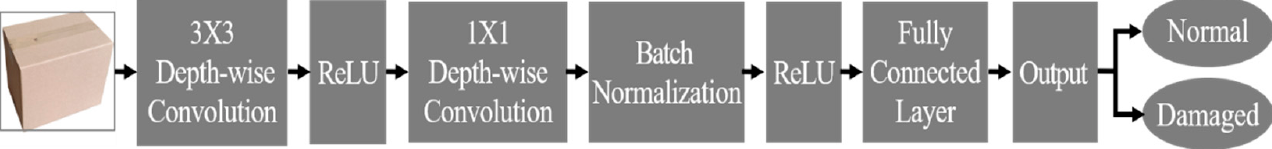
Figure 5. A flow chart for classification of parcel boxes. 3.4. Dataset of Materials and Method The experiment for the recognition and classification of damaged parcel boxes used in this paper was performed by Google, as shown in Table 3. Google Colaboratory (Colab) is built to perform cloud-based deep learning works based on Jupyter notebooks. Colab